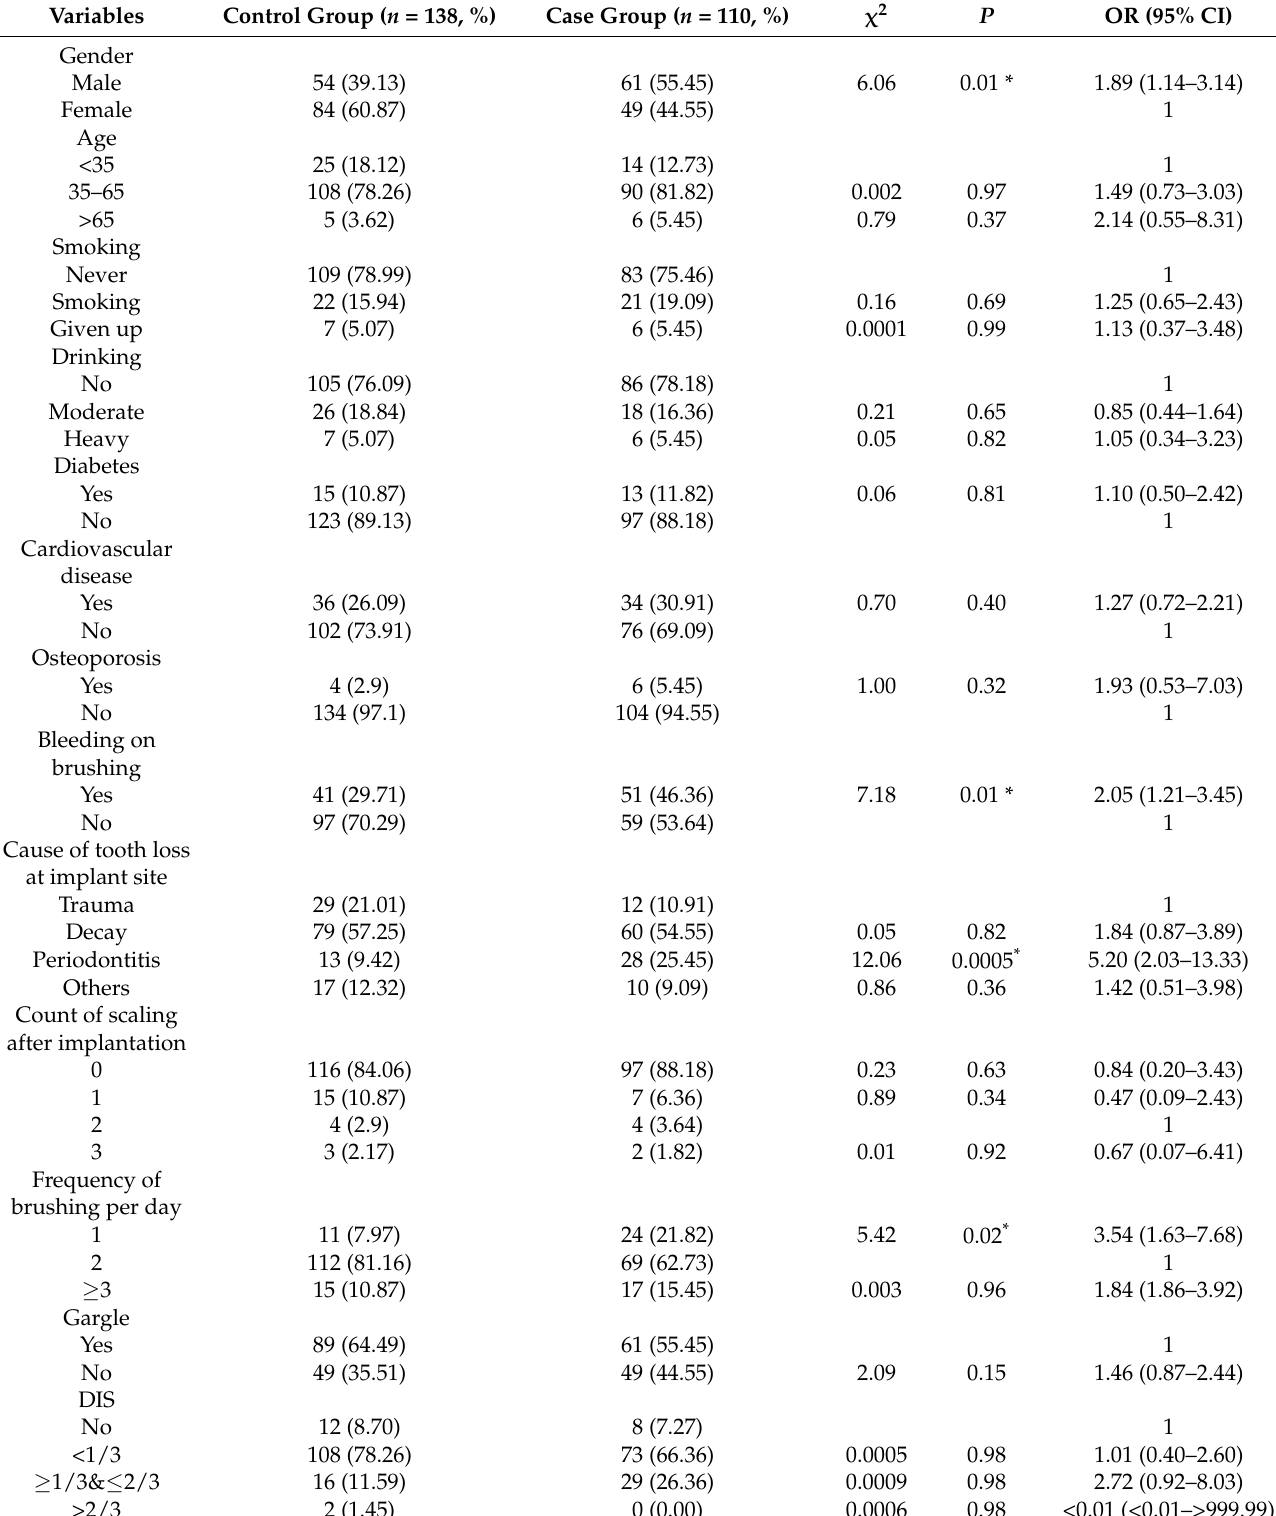
Table 1. Univariate Logistic regression analysis of patient-related